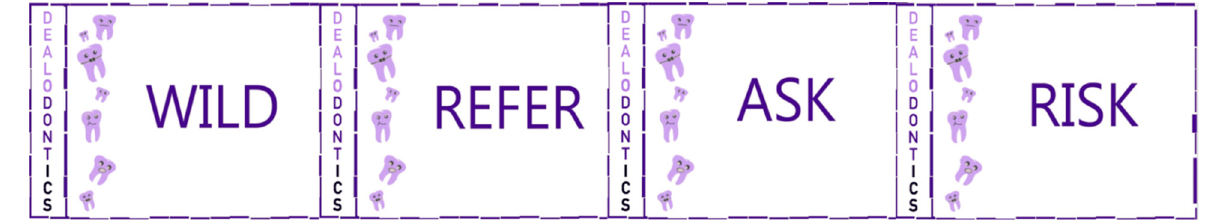
Figure 2. There are four types of team cards.